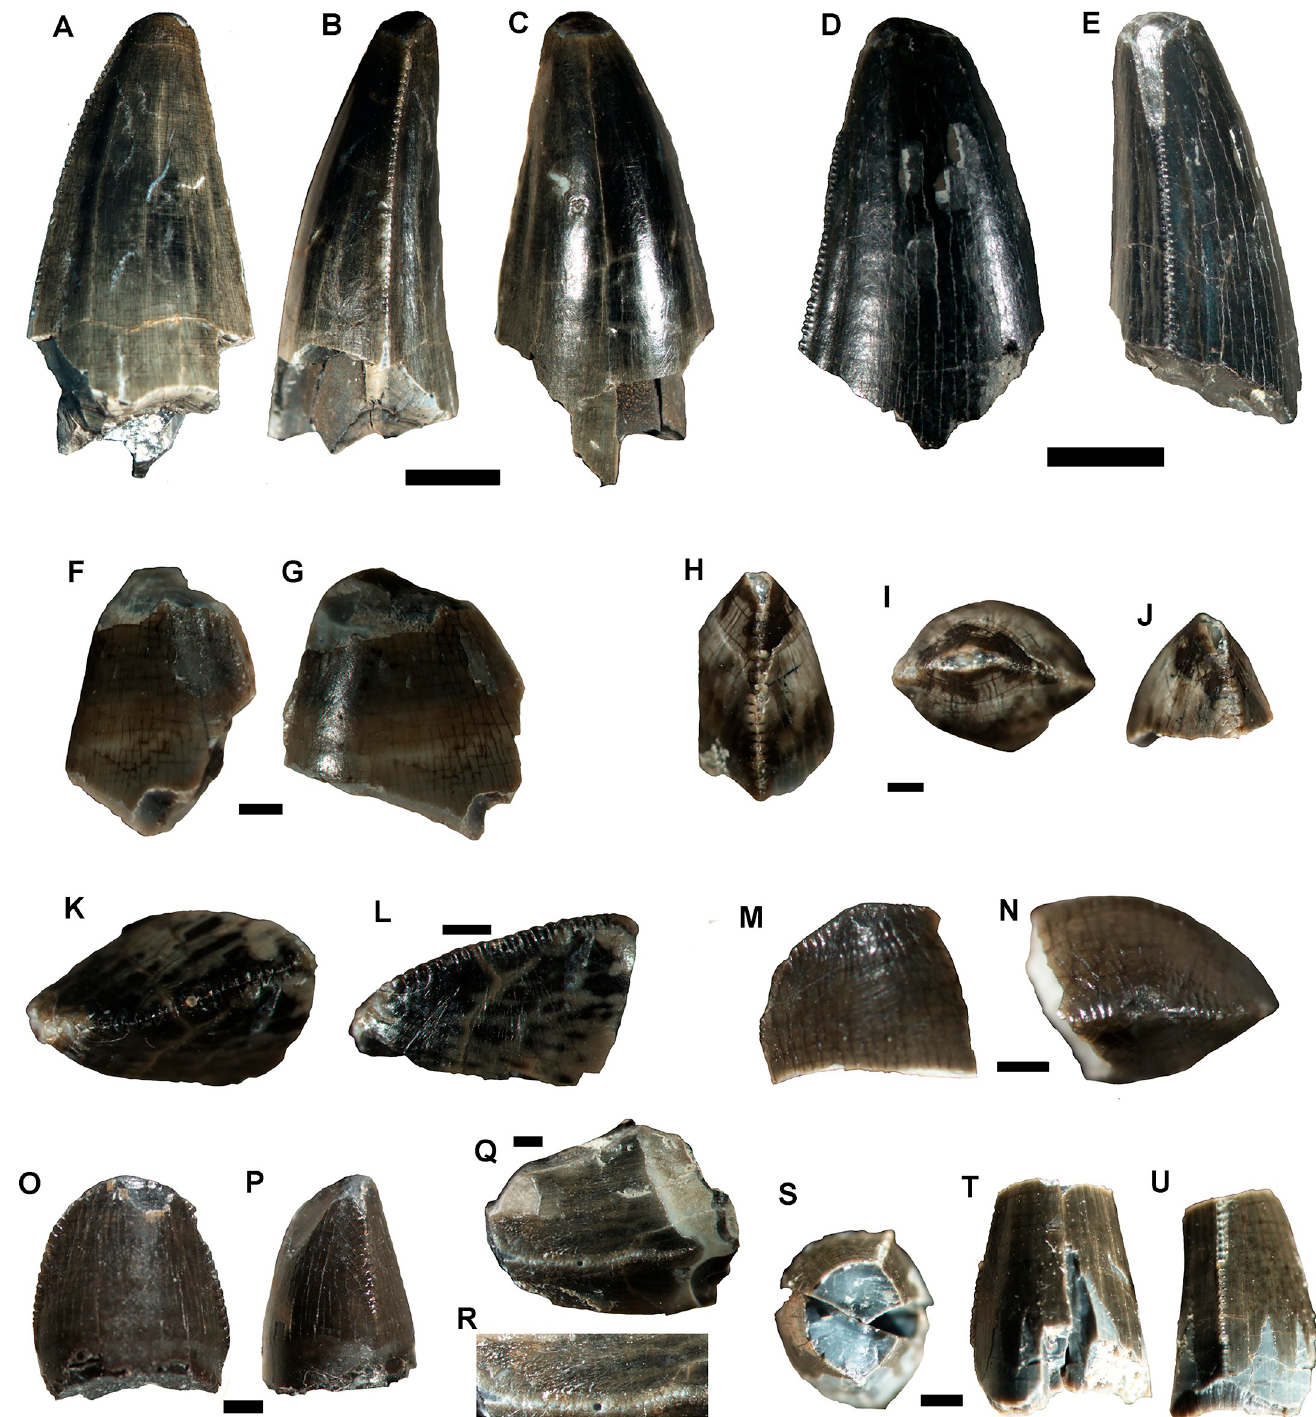
Fig 5. Peirosaurid teeth. MPM-PV-18805.5 complete crown in lingual (A), mesial (B) and labial (C) views. MPM-PV-18805.6 complete crown in labial (D) and distal (E) views. MPM-PV-18805.7 fragmented crown in mesial (F) and lingual (G) views. MPM-PV-18805.8 almost complete crown in mesial or distal (H), apical (I) and mesial or distal (J) views. MPM-PV-18805.9 fragmented crown in mesial or distal (K) and labial (L) views. MPM-PV-18805.10, fragmented crown in labial (M) and apical (N) views. MPM-PV-18805.11, complete crown in lingual (O) and mesial (P) views. MPM-PV-18805.12, fragmented crown in mesial or distal (Q) and detail of the denticles (R). MPM-PV-18805.13, crown missing the tip in apical (S), lingual (T) and distal (U) views. Scale bars (A-E) = 5 mm; (F-U) = 1 mm.